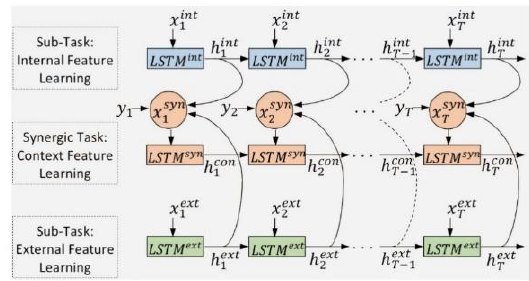
Figure 5. Structure of multi-task LSTM encoder [16].